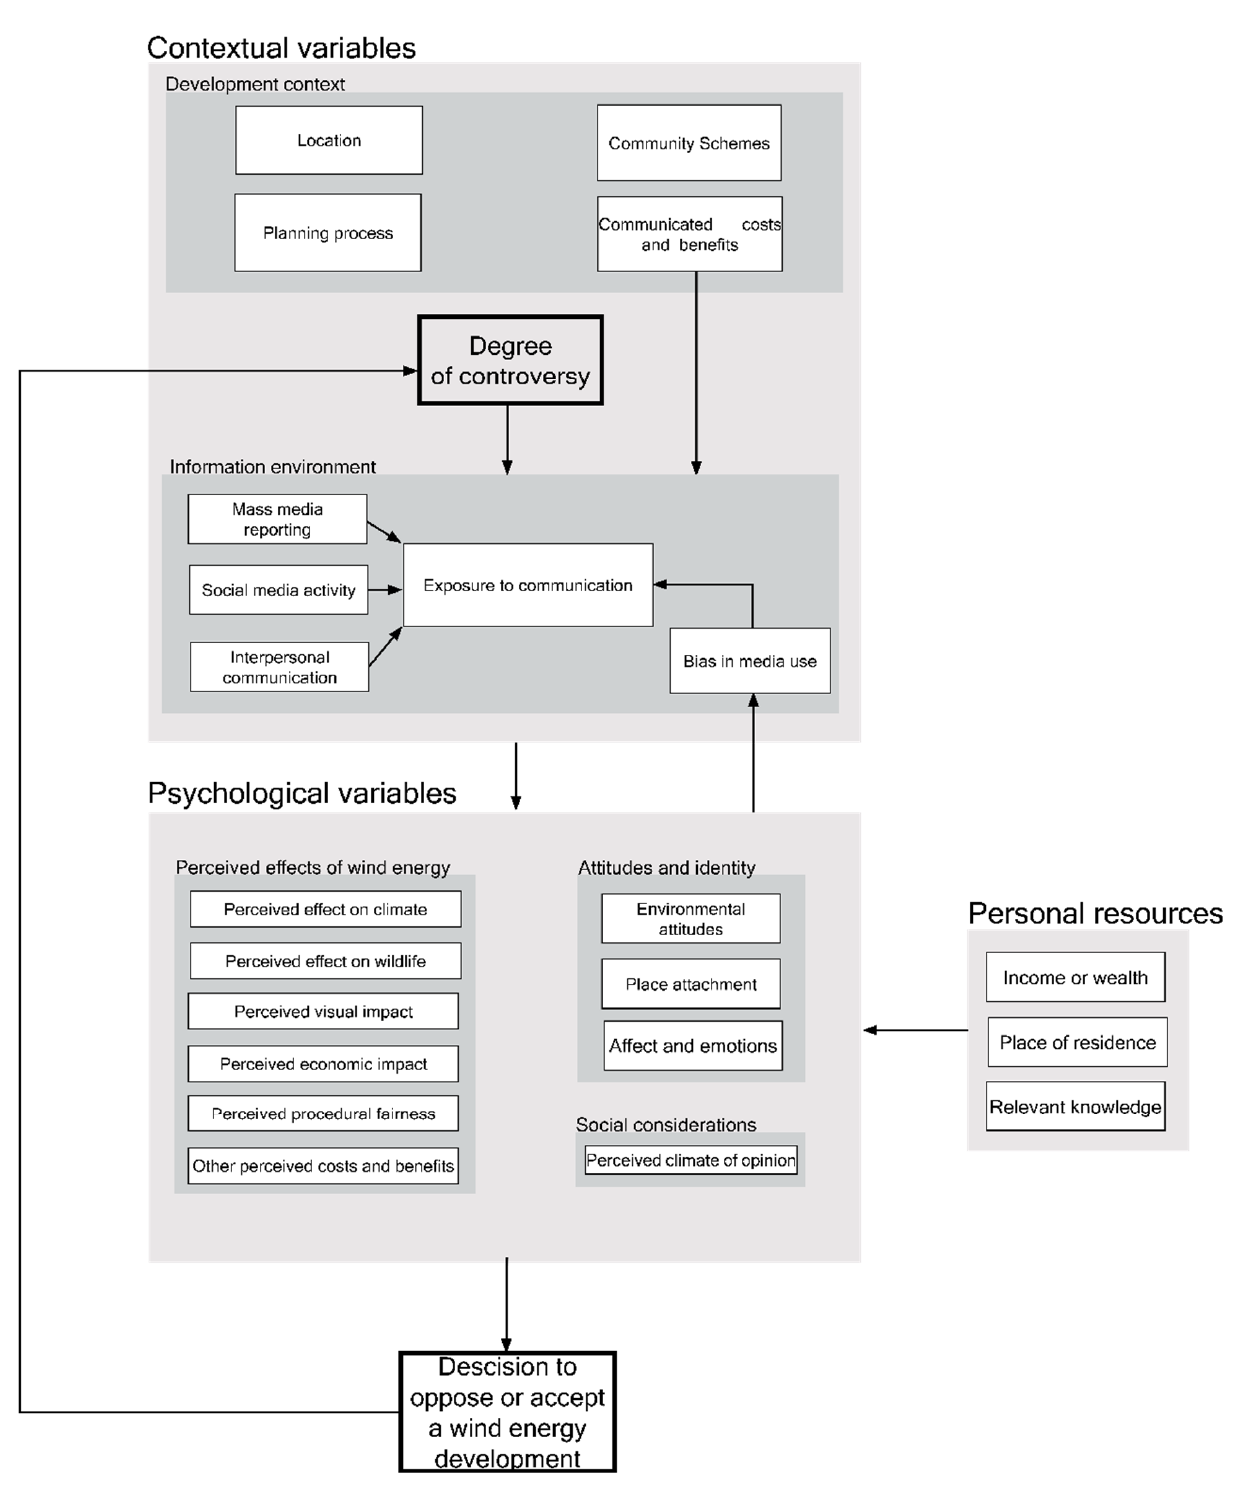
Figure 1. Theoretical framework of the social acceptability of wind energy. Contextual variables feed into the degree of controversy, which feeds into the information environment, and the information environment feeds into psychological variables. Personal resources also feed into the section with psychological variables. Here, the information is processed by the individual. An evaluation of the costs and benefits is performed, resulting in either opposing or accepting wind energy, which leads to a larger or smaller degree of controversy.